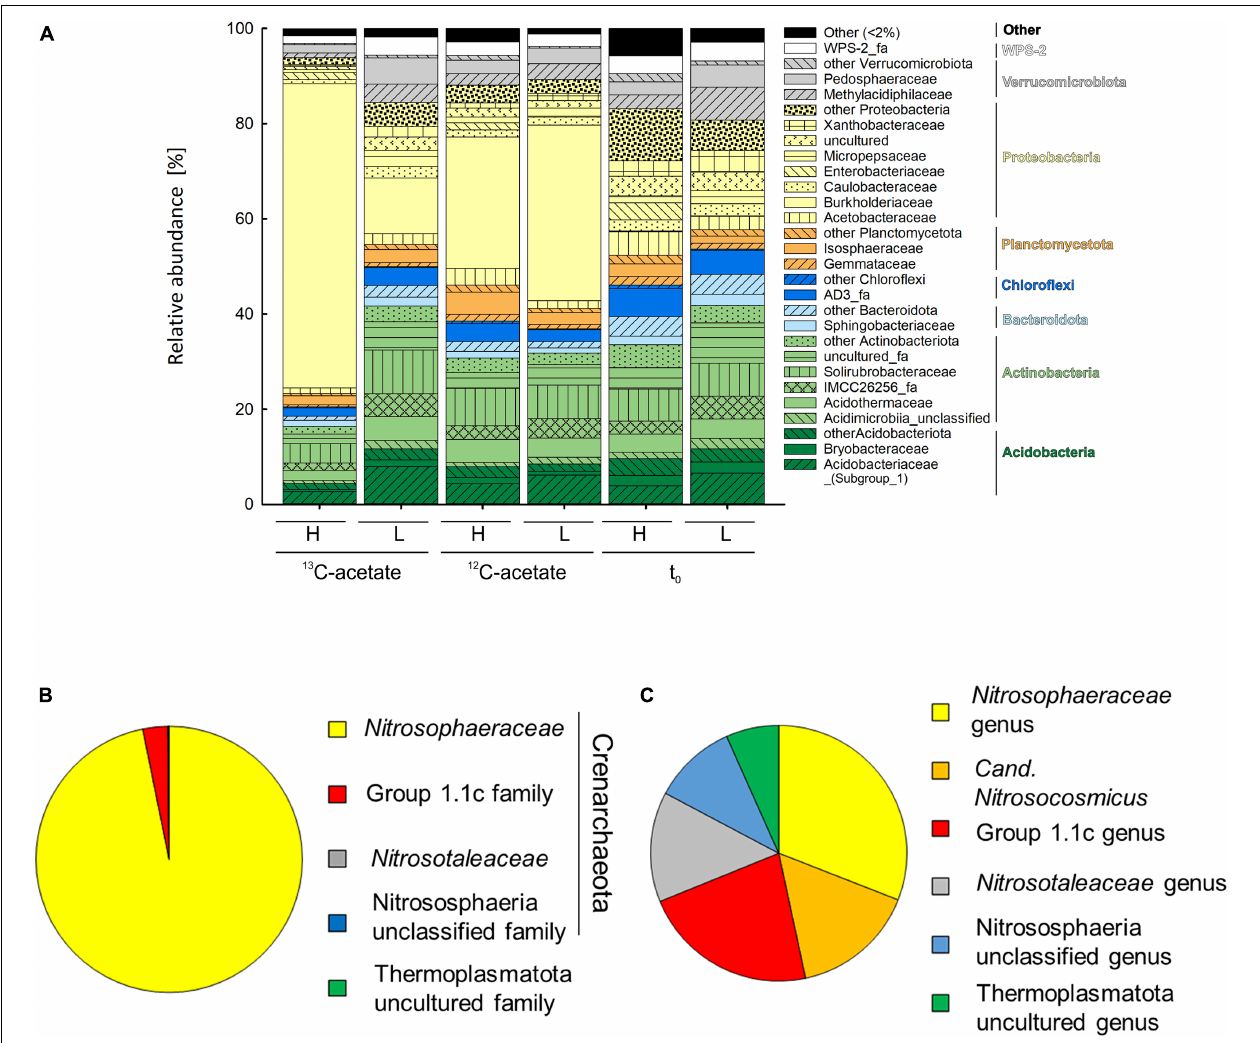
FIGURE 2 | Mean relative abundance of bacterial families ( > 2% of relative abundance in at least one sample, A ) delineated from analysis of density resolved 16S rRNA sequences retrieved from cryoturbated peat circle sediments prior to and after 16 days of anoxic incubation (see Figure 1 ). Values are means of triplicate incubations. Heavy (H) and Light (L) indicate fractions representing relative abundances of 13 C-labeled and unlabeled 16S rRNA sequences after isopycnic centrifugation (see section “Materials and Methods” for further details) where sequences have been retrieved from. 13 C- and 12 C-acetate refer to treatments with 13 C- and 12 C-acetate, respectively. t 0 indicates peat circle sediments prior to incubation. Relative abundances in amplicon libraries of archaeal family (B) and genus (C) level taxa in all samples are displayed. Please note that Log 10 of sequence counts per genus are given to highlight rare genera (C) . For a more detailed overview of archaeal taxa see Supplementary Figure S7